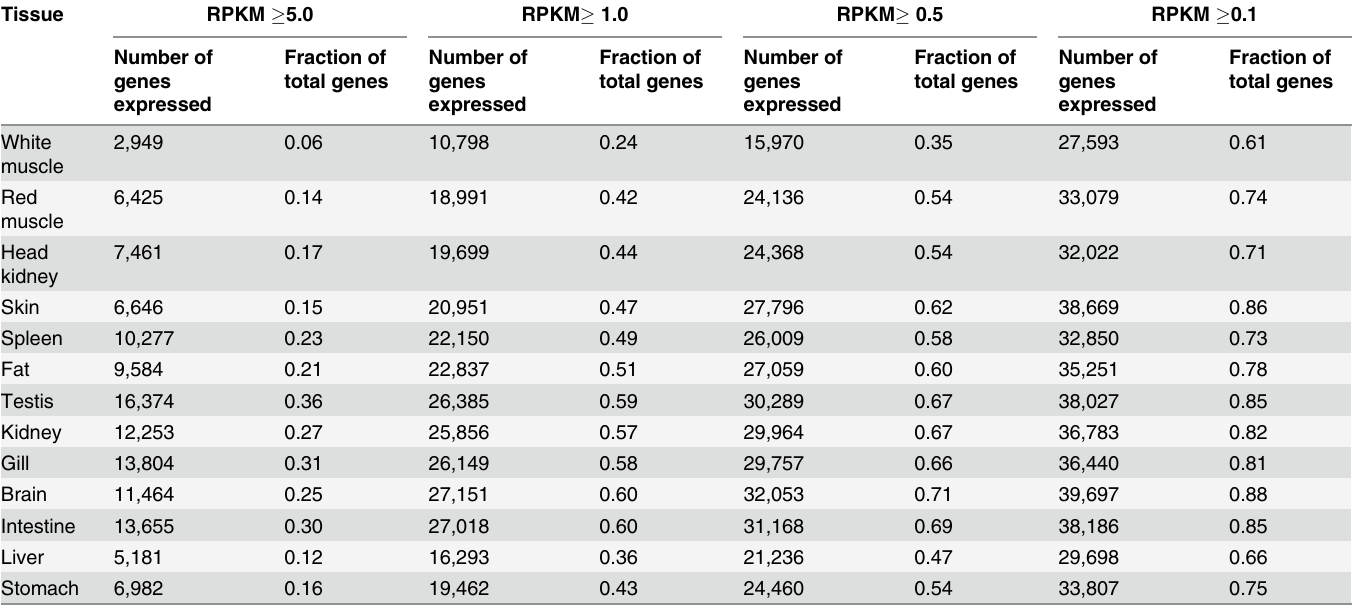
Table 4. Number of genes expressed in 13 rainbow trout tissues at different RPKM threshold. Tissue RPKM (cid:1) 5.0 RPKM (cid:1) 1.0 RPKM (cid:1) 0.5 RPKM (cid:1)